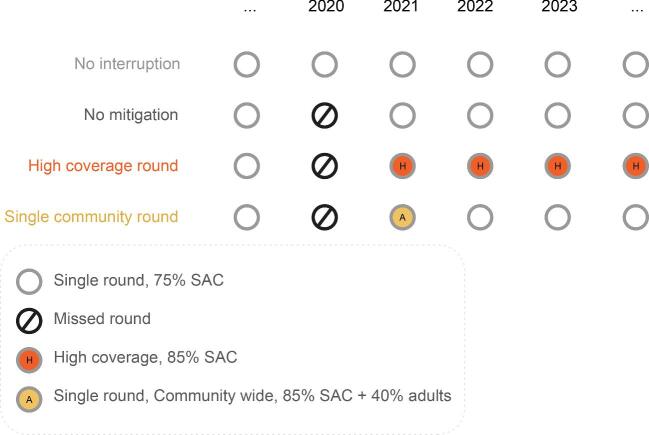
Visual representation of the scenarios and mitigation strategies analysed.